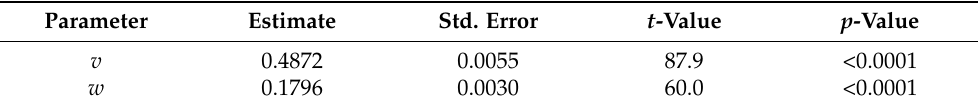
Table 9. Parameter estimates for the stand-level volume function (Equation (10)). The root mean